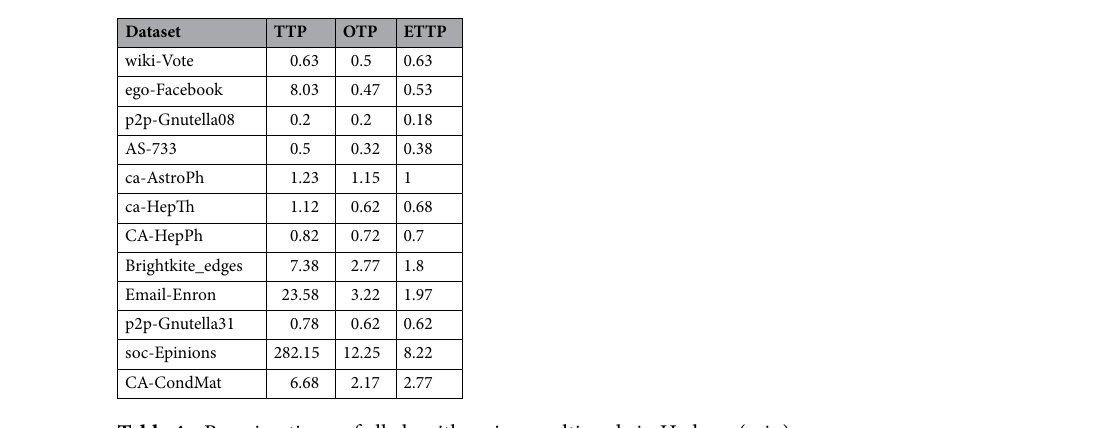
Table 4. Running times of all algorithms in a multi node in Hadoop